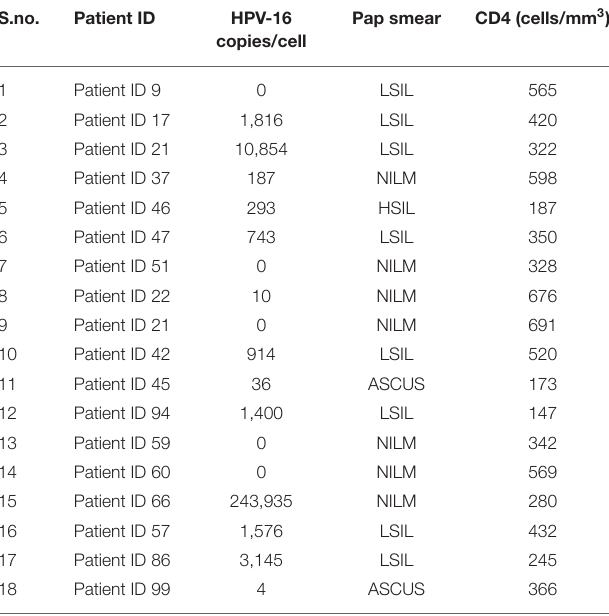
TABLE 1 | Comparison of cytological grading with PCR hybridization. Group Cytology